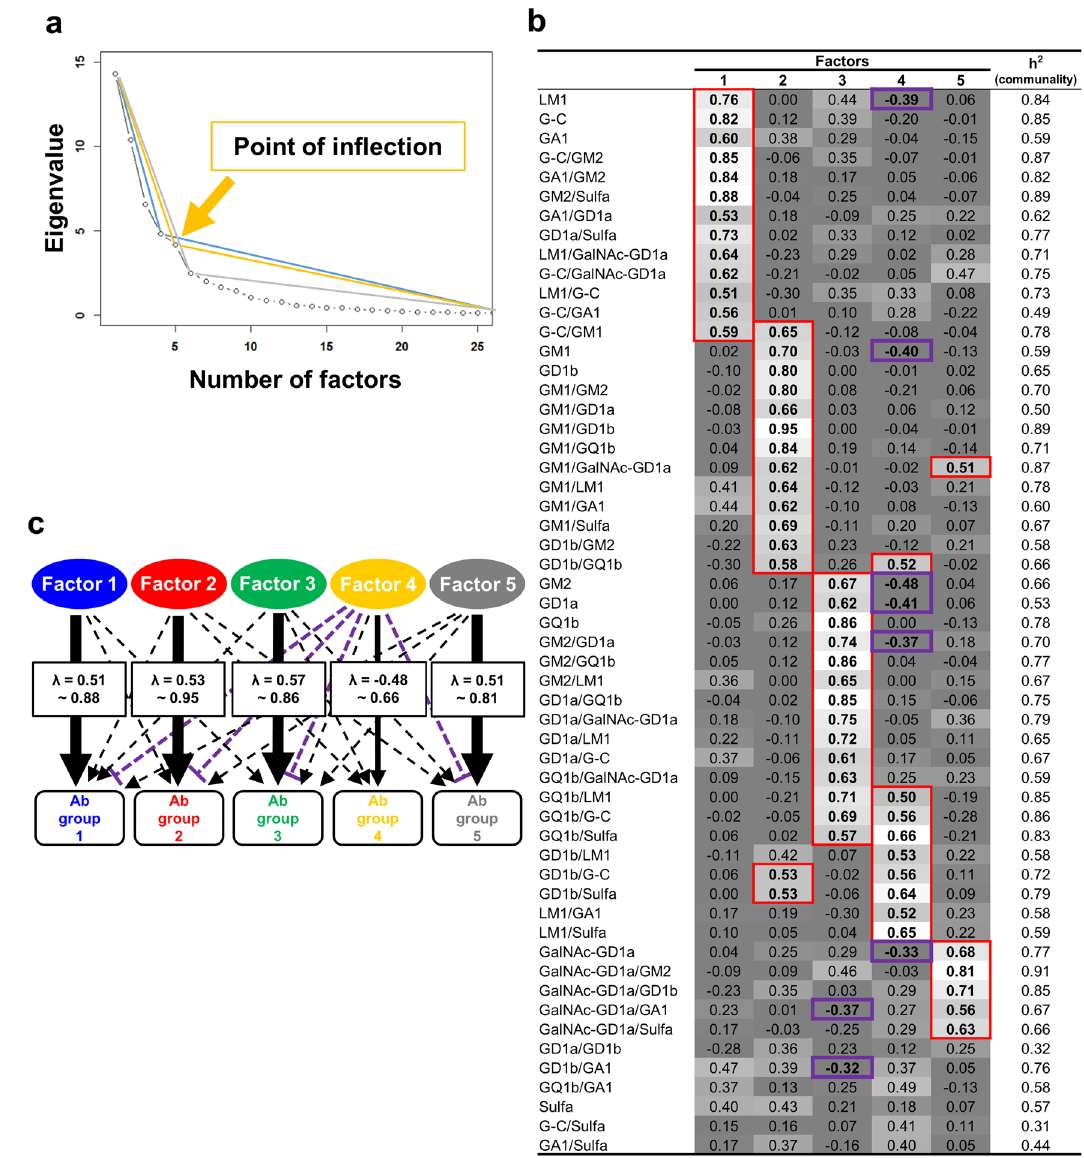
Figure 5. Exploratory factor analysis (EFA) of IgG glycoarray data from GBS patients. ( a ) The point of inflection of the scree plot with the eigenvalues and number of factors indicated that four, five, or six factors were the adequate number of common factors. ( b ) Factor loadings higher than 0.5 (shown in red boxes) were selected as related variables forming the particular factors. We identified five factors: Factor 1 had high factor loadings (≥ 0.5) in LM1, G-C, asialo-GM1 (GA1), and their complexes. Factor 2 had high factor loadings in GM1, GD1b, and their complexes. Factor 3 had high factor loadings in GM2, GD1a, GQ1b, and their complexes. Factor 4 had high factor loadings in GD1b complexes, GQ1b complexes, and LM1 complexes. Factor 4 also had moderately negative factor loadings in LM1, GM1, GM2, GD1a, GM2/GD1a, and GalNAc-GD1a (shown in purple boxes). Factor 5 had high factor loadings of GalNAc-GD1a and their complexes. Six glycolipid antibodies were not categorized into any factors; this could occur when a variable (i.e., glycolipid antibody) was not associated with other variables. ( c ) A model of associations between Factors 1 to 5 with glycolipid antibody (Ab) groups 1 to 5. Each factor was associated with antibodies belonged to distinct Ab group strongly (λ ≥ 0.5) and some antibodies belonged to the other groups moderately (λ ≥ 0.3). Factor 4 was negatively associated with several glycolipid antibodies moderately. A parameter, h 2 , indicates communality that is the ratio (0 to 1) of variance explained by the five